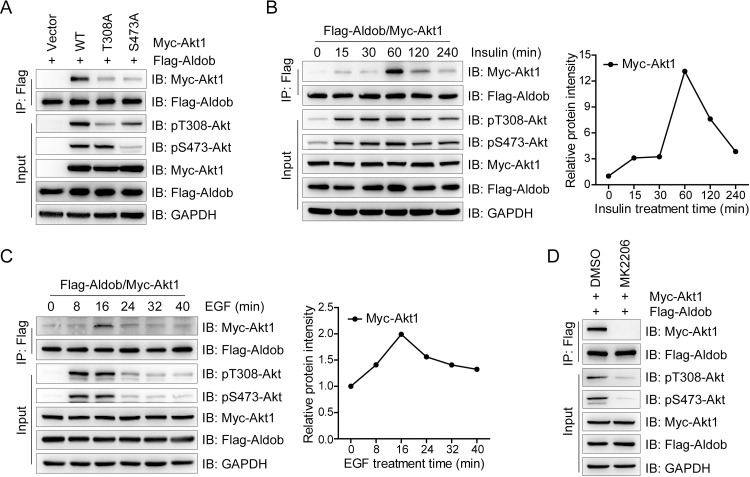
Aldob preferentially interacts with the phosphorylated species of Akt1.(A) IB analysis of anti-Flag IP and WCL derived from Huh7 cells transfected with the indicated constructs. T308A and S473A indicated that threonine at position 308 and serine at position 473 of Akt1 were replaced by alanine, respectively. (B and C) IB analysis of anti-Flag IP and WCL derived from Huh7 cells transfected with Flag-Aldob and Myc-Akt1. Resulting cells were serum-starved for 24 hours and then stimulated with 0.1 μM insulin (B) or 100 ng/ml EGF (C). At the indicated time points, WCL were harvested for Flag-IP and further for IB analysis (left). The relative intensity of Myc-Akt1 immunoprecipitated by Flag-Aldob was quantified (right). (D) IB analysis of anti-Flag IP and WCL derived from Flag-Aldob and Myc-Akt1 transfected Huh7 cells that were treated with DMSO or MK2206 (1 μM) for 24 hours before harvesting. The data underlying this figure can be found in S1 Data. Aldob, aldolase B; EGF, epidermal growth factor; IB, immunoblot; IP, immunoprecipitation; WCL, whole cell lysate.